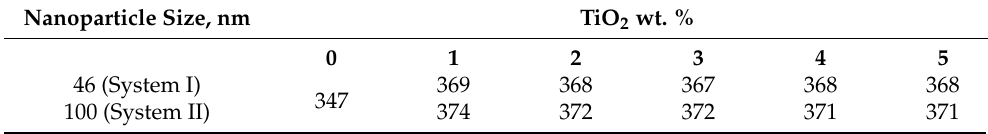
Table 3. Decomposition onset temperatures for TiO 2 /EP nanocomposites. Nanoparticle Size,